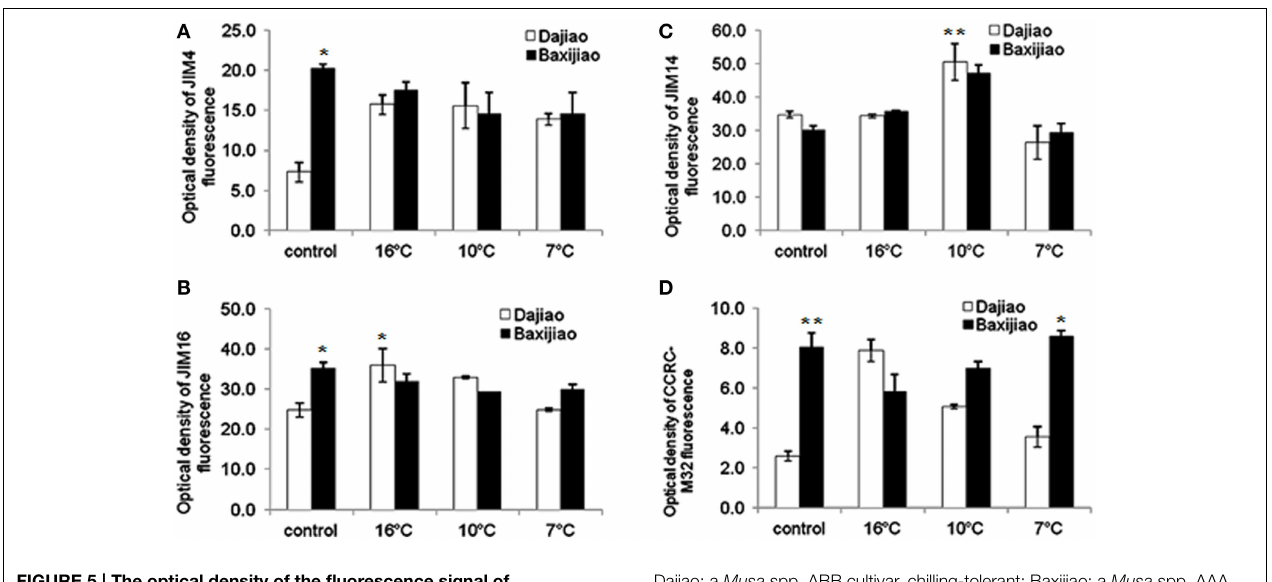
Dajiao: a Musa spp. ABB cultivar, chilling-tolerant; Baxijiao: a Musa spp. AAA cultivar, chilling-sensitive. Values marked with star were considered significant at P < 0 . 05 while values marked with two stars were considered significant at P < 0 . 01 .